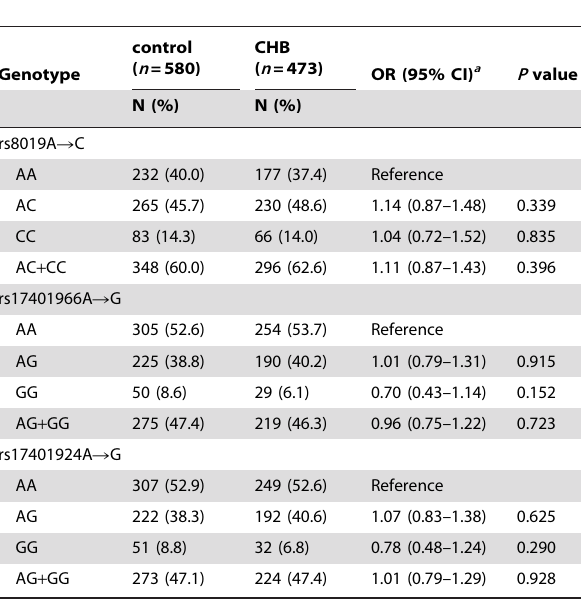
Table 2. KIF1B genotype frequencies and ORs for the association with CHB in Chinese population.